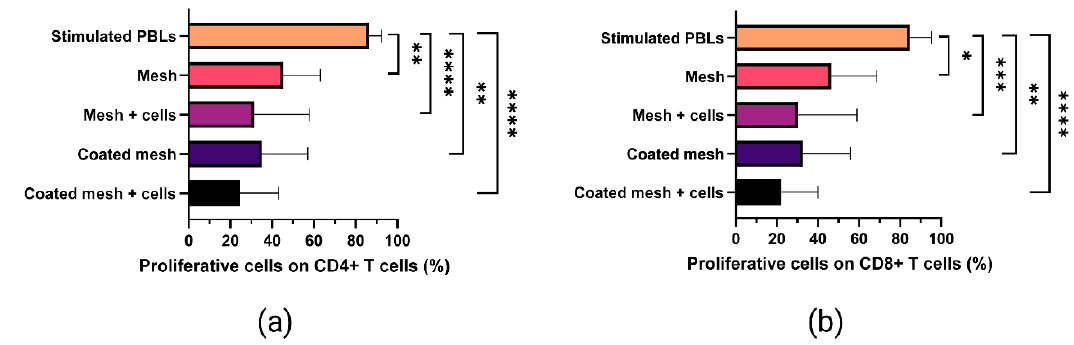
Figure 6. Proliferative ability of in vitro-stimulated T cells co-cultured with fibrin-coated meshes seeded with cells. Pe- ripheral blood lymphocytes (PBLs) from three human donors were labeled with carboxyfluorescein succinimidyl ester (CFSE) and stimulated in vitro with T cell activation/expansion beads. During in vitro stimulation, PBLs were co-cultured with uncoated surgical meshes (Mesh), uncoated surgical meshes seeded with menstrual blood derived-stromal cells (MenSCs, n = 3) (Mesh + cells), fibrin-coated PP meshes (Coated mesh), and fibrin-coated PP meshes seeded with MenSCs (Coated mesh + cells). Coated meshes received a bilayered fibrin coating with 5 mg/mL fibrinogen + 5.5 IU/mL thrombin solutions in PBS. CFSE low cells (proliferative T cells) are presented in terms of percentage on CD4+ ( a ) and CD8+ ( b ) cells. Mean ± SD are represented. Mann-Withney tests allowed to compare each group with the positive control (stimulated PBLs without meshes and cells). * p < 0.05; ** p < 0.01; *** p < 0.001; **** p < 0.0001.